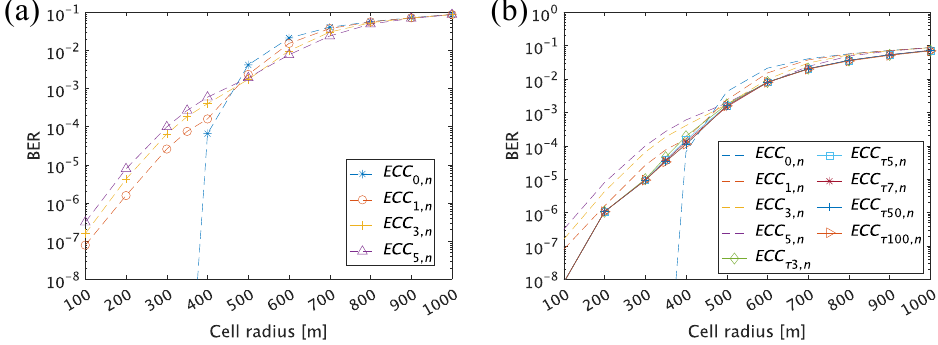
Figure 9. BER with different ECC ϕ , n settings; ( a ) BER comparison with a fixed ECC. ( b ) BER compar- ison with an adaptive